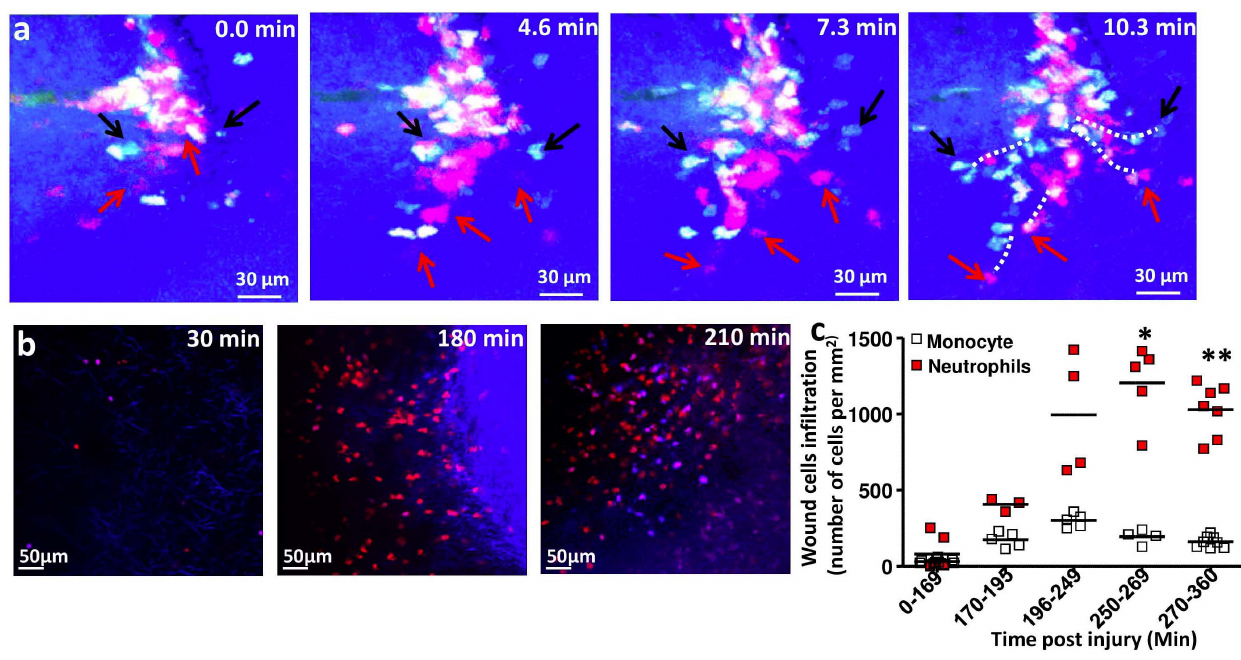
Figure 3. Monocytes infiltrated the wound bed concomitantly with neutrophils. ( a ): Time lapse picture series representing concomitant invasion of the wound bed by monocytes (black arrows) and neutrophils (red arrows). The SHG signal is in blue, the ECFP signal in cyan, and the PE signal in red. Representative track paths are represented by white dashed lines. ( b ) Representative TPLSM pictures of the wound deep skin layer from MacBlue 6 CX3CR1 gfp/ + mice at several time points after wounding. Mice were injected intravenously with 10 m g of Ly6G-PE antibody before wounding. The SHG/ECFP signal is in blue, and the PE signal in red. ( c ) The graph shows the quantification of Ly6G + and ECFP + cell density from TPLSM pictures taken 15 to 360 min post-wounding in MacBlue 6 CX3CR1 gfp/ + mice. Each dot represents a mean of number of ECFP + cells calculated from 30 to 50 different fields (100 6 100 m m) from 3 to 8 different mice. Time points were compared using one way ANOVA followed by Bonferroni adjustment. *p , 0.05; **: p , 0.01.